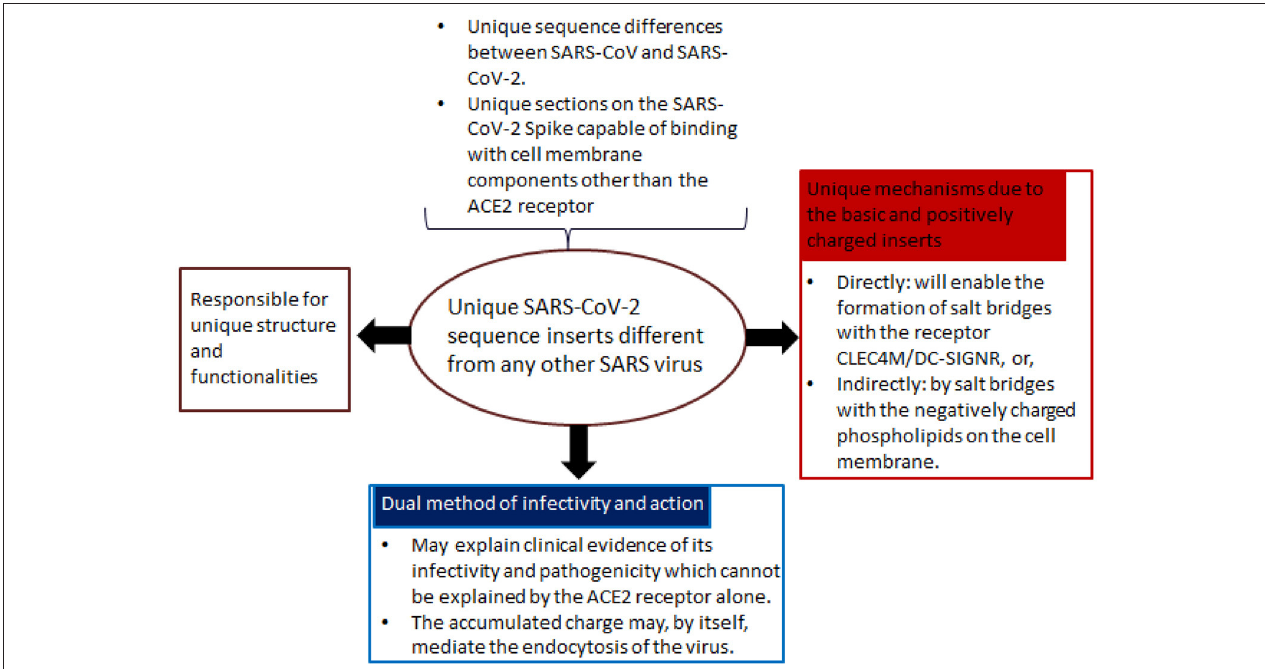
FIGURE 2 | Rationale for the development of Biovacc-19. In Sørensen et al. (2020), the developers proposed a radically new approach for vaccine design: firstly, they identified unique sequence inserts into the virus, different from other SARS viruses; secondly, based on these unique inserts, a singular mode of action is identified, both in terms of its infectivity and pathogenicity. Based on their analysis, SARS-CoV-2 can enter cells without using the ACE2 main receptor. This is important for treatment and vaccine development strategies as the binding with cell membrane components is strongly facilitated by the unique molecular structure of the positively charged Spike trimer